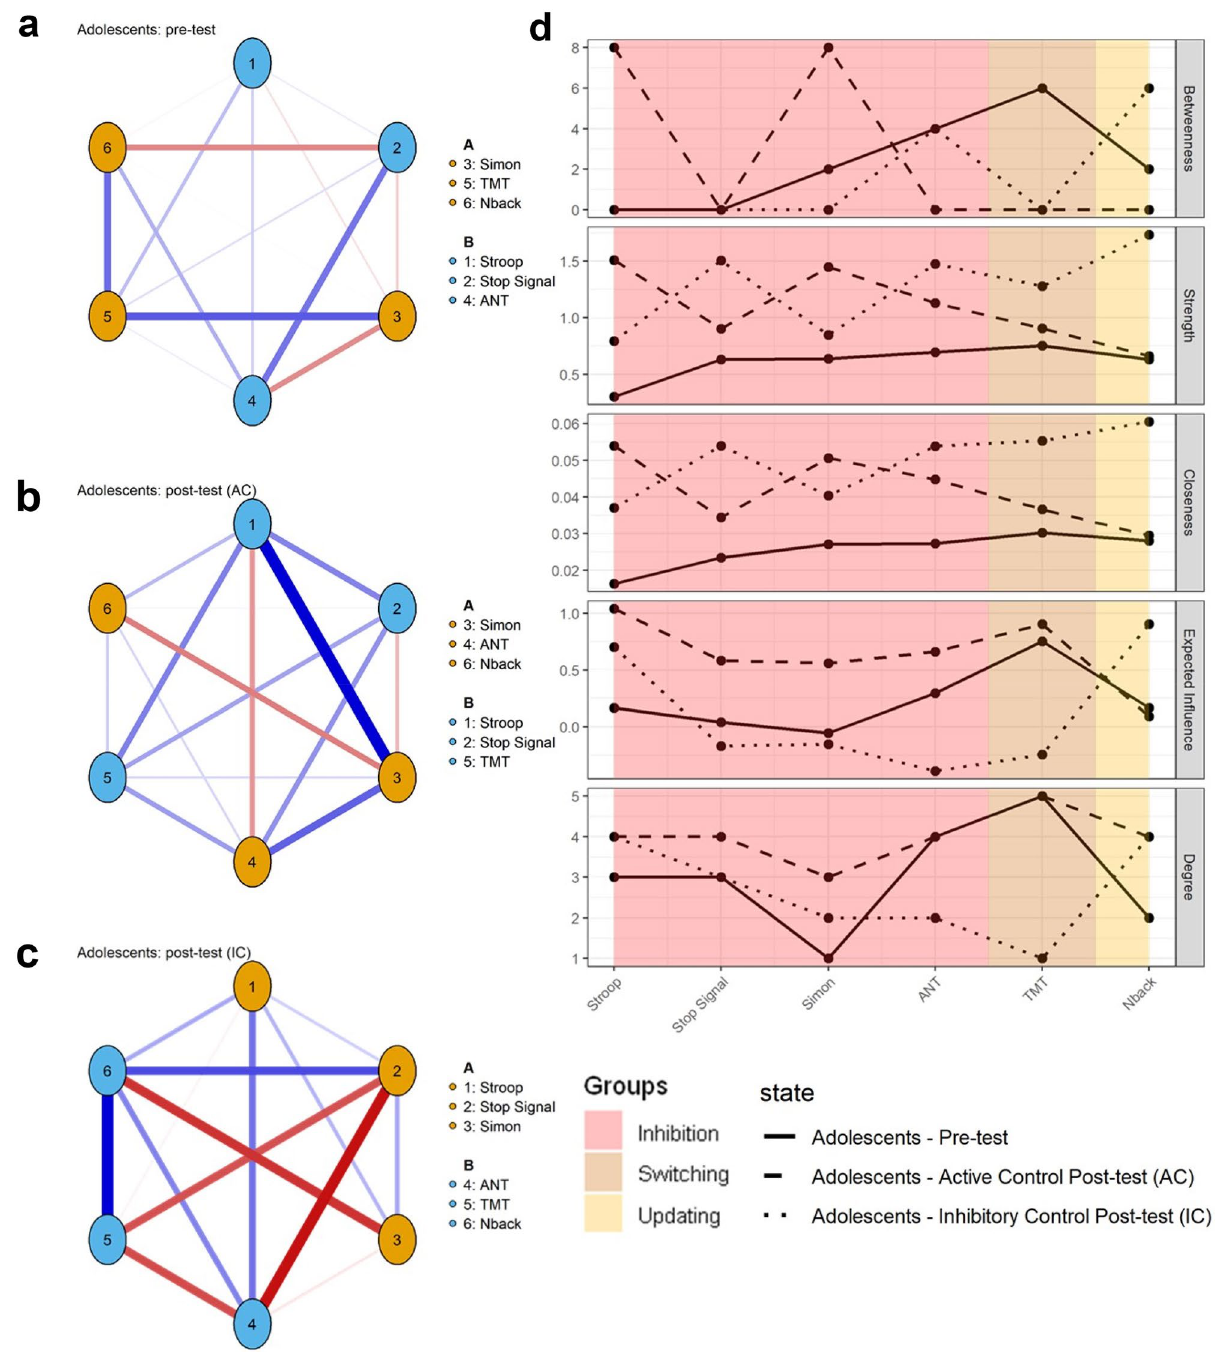
Figure 3. Six-nodes networks for adolescents, before ( a ), after active control training (AC group; b ) and after inhibitory control (IC group; c ) training with the corresponding centrality indices ( d ). Color of nodes correspond to the communities. Each number in the networks corresponds to an EF task (see details in the